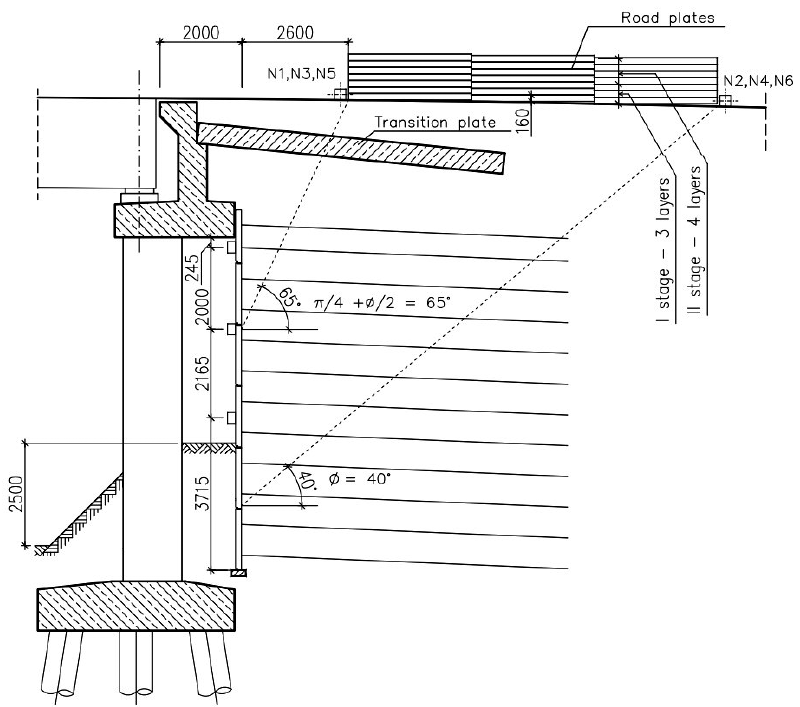
Figure 4. Arrangement of loading road plates – longitudinal view, scheme of load transfer to reinforced earth